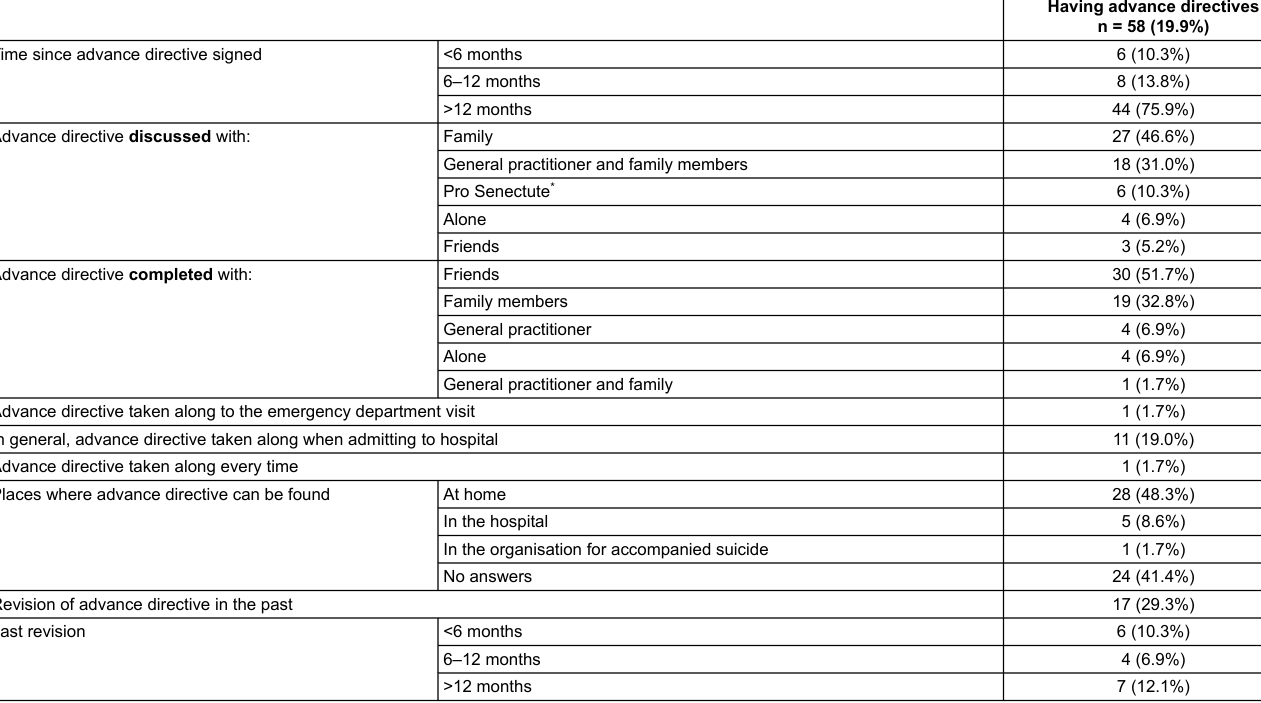
Table 2: Survey results for patients having advance directives.